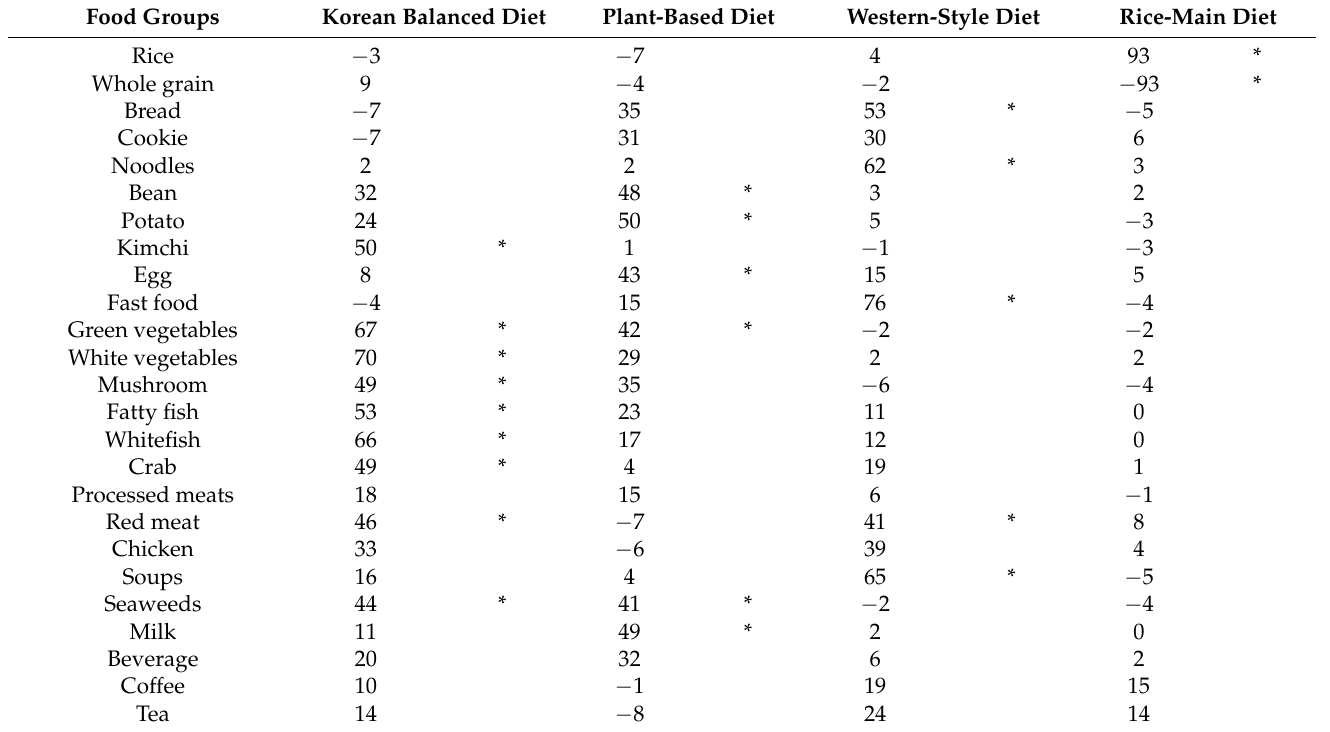
Table 1. The factor-loading values of the predefined 29 food groups in each dietary